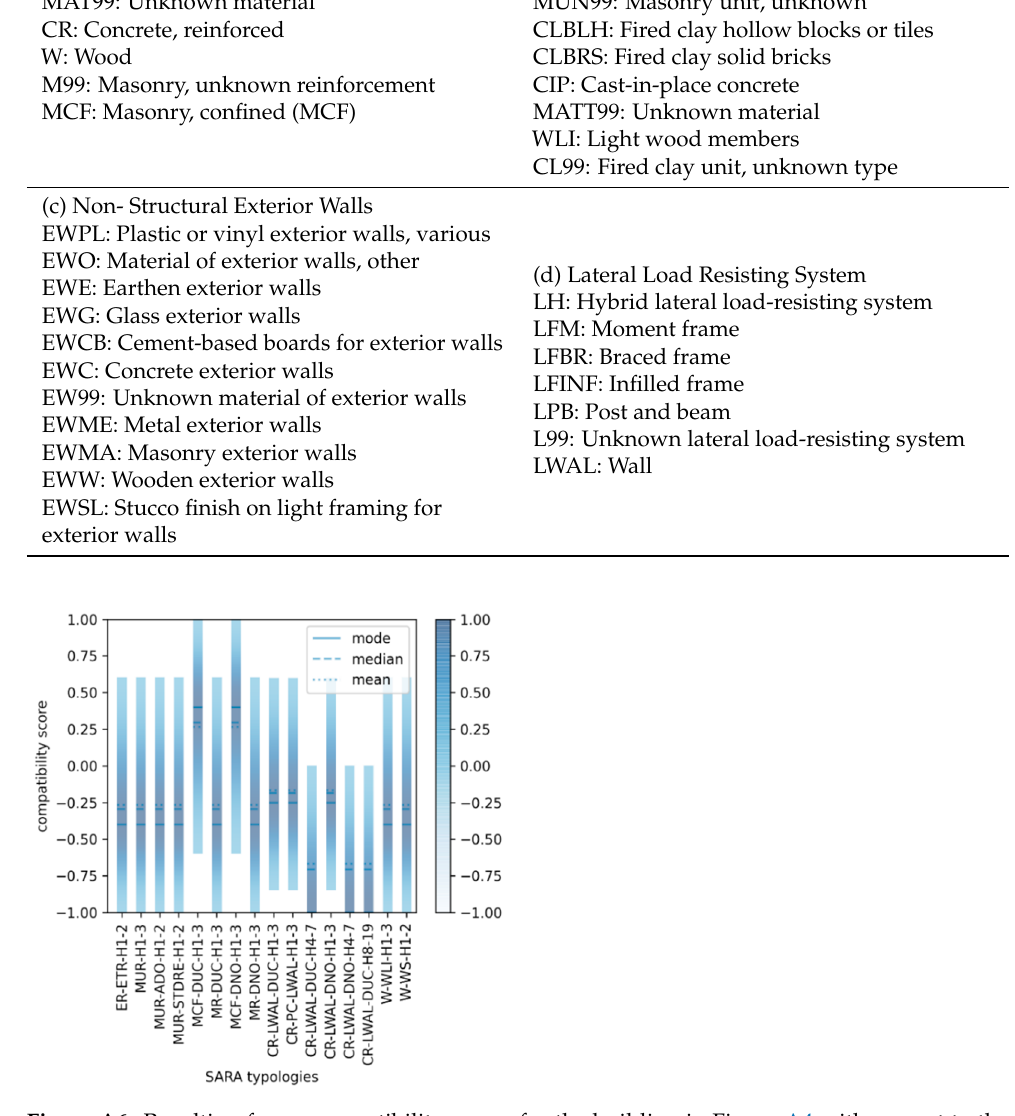
Figure A6. Resulting fuzzy compatibility scores for the building in Figure A4 with respect to the SARA typologies. The solid and dashed segments represent the equivalent defuzzified values according to the mode, median, or mean values of the triangular fuzzy